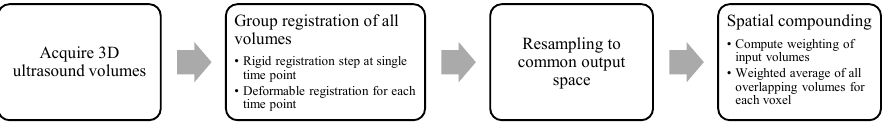
Figure 2. Workflow of TEE compounding for the mitral